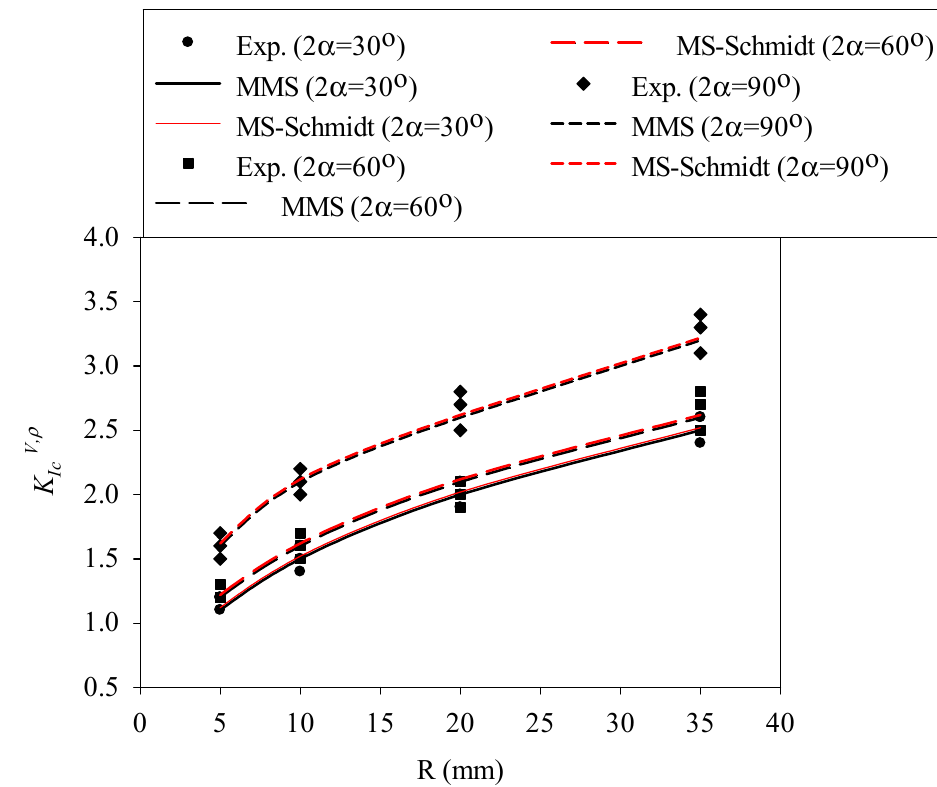
Figure 8. Variation in K IcV, ρ with specimen size for RVNBD specimens made of GPPS. Predictions provided by the MS–Schmidt and the MMS criteria, and experimental data.